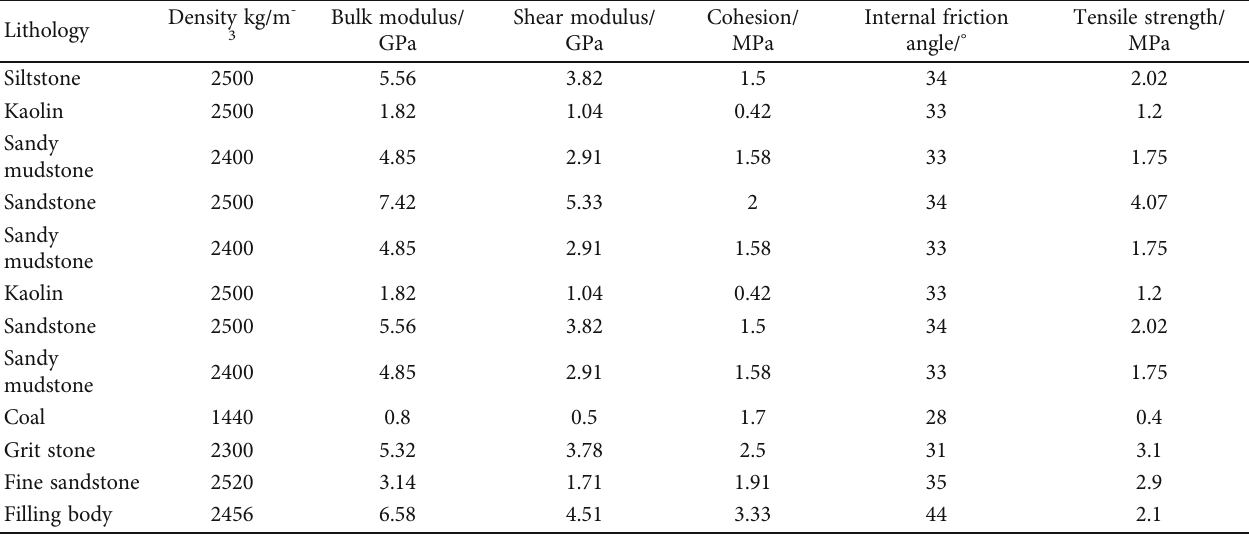
Table 5: Mechanical parameters of rock strata.